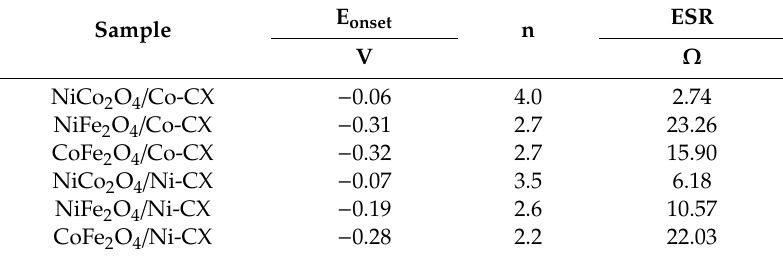
Table 6. Parameters obtained from LSV at 4000 rpm (values of n refer to K-L fitting for data at − 0.8 V) and equivalent series resistance (ESR) calculated from the Nyquist